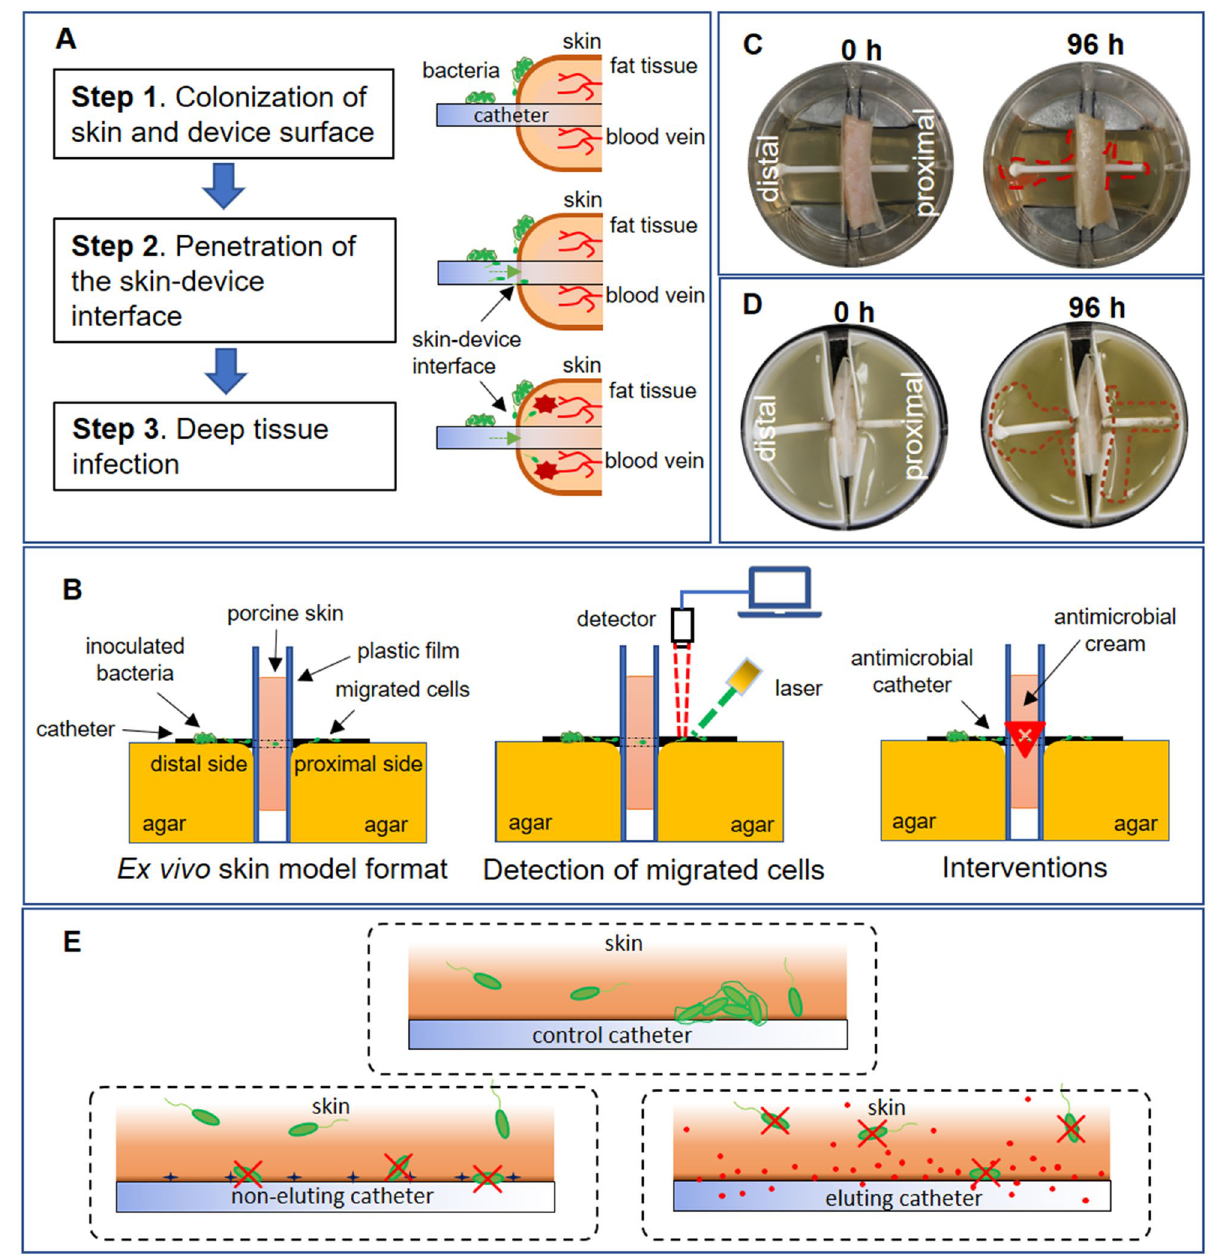
Figure 1. Ex vivo model to simulate pathogenesis of indwelling device-associated infection. ( A ) Proposed route by which bacterial cells penetrate the skin-device interface from superficial to deep tissue. ( B ) Schematic of ex vivo model. Bacterial cells inoculated on distal side of skin-device interface migrate to proximal side. Migration was monitored by fluorescence microscopy, confocal microscopy, and IVIS bioluminescence. Different interventions are evaluated to determine the comparative time of microbial translocation. ( C ) Photographic images of ex vivo model. Left: Initial inoculation of E. coli RP437/pRSH103. Right: E. coli RP437/ pRSH103 biofilm on distal and proximal sides of agar 96 h post-inoculation ( D ) Photographic images from of ex vivo model using 3D-printed molds. Left: Initial inoculation of E. coli Xen14. Right: E. coli Xen14 96 h post-inoculation (areas of growth roughly outlined in dotted red line for clarity). ( E ) Schematic showing three scenarios studied in this work: bacterial interactions with tissue-control catheter interface, tissue-non-eluting catheter interface, and tissue-eluting catheter